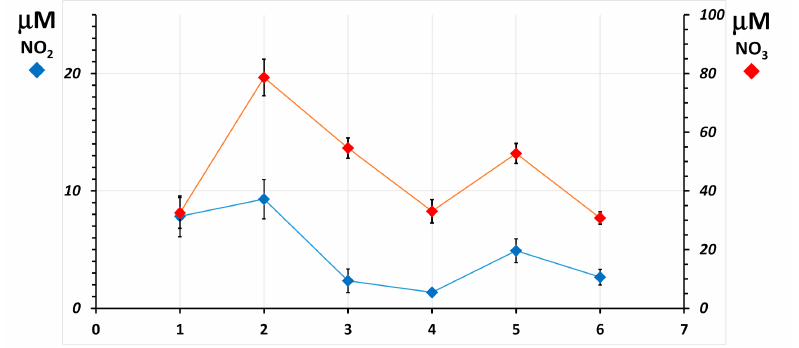
Figure 5. Line plot of the concentration of nitrite (blue diamonds) and nitrate (red diamonds) in RBC, normalized for hemoglobin concentration as µ moles per millimole hemoglobin measured in one subject of the Concordia Arctic Research Station 2015 study. Blood samples were obtained from the subject before the journey ( 1 ) and at 3 ( 2 ), 7 ( 3 ), 20 ( 4 ), and 90 ( 5 ) days after arrival at the Station and